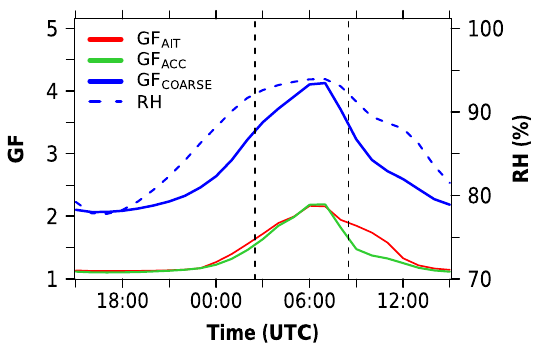
Figure 6. Diurnal cycle of the median GF (%) of GF AIT (red), GF ACC (green), GF COARSE (blue) and RH (%) (blue dashed) in the lowest 1500ma.g.l. over the Ivory Coast (7.5–3 ◦ W, 4–10 ◦ N) from 2 July 15:00UTC to 3 July 15:00UTC. The vertical dashed lines denote the three phases introduced in Fig. 3.